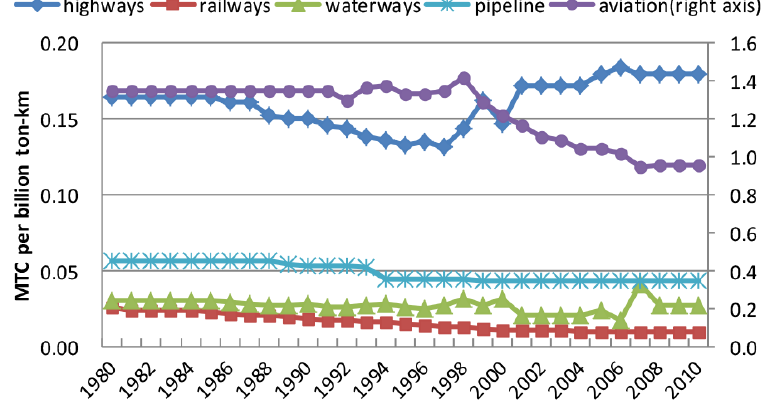
Figure 5. CO 2 emission intensity in different transport